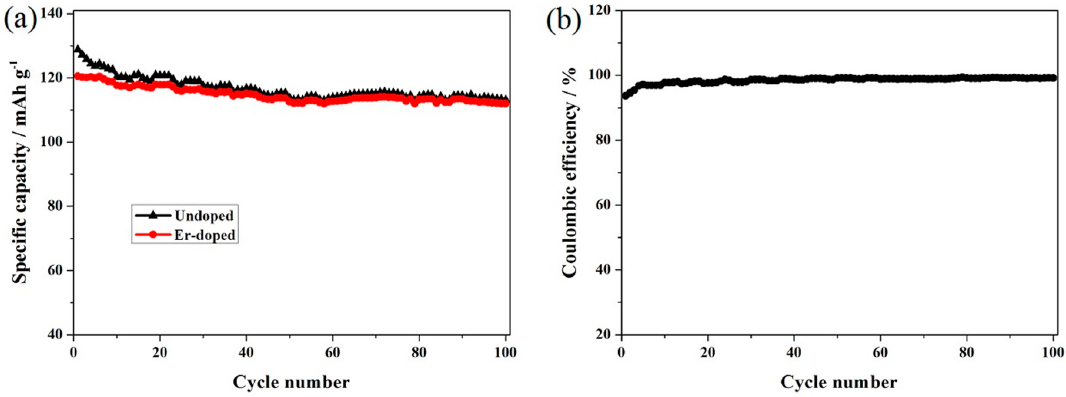
Figure 5. ( a ) Long cycling performance and ( b ) coulombic efficiency of the Er-doped LiNi 0.5 Mn 1.5 O 4 at 0.5 C.